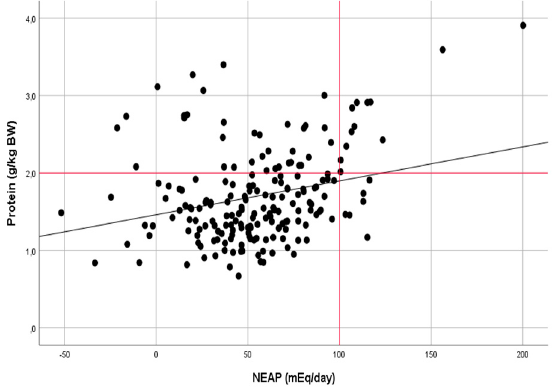
Figure 3. Relationship between the dietary protein intake (g · kg − 1 · day − 1 ) and NEAP (mEq · day − 1 ) in athletes of aerobic sports (r = 0.274, p < 0.001).